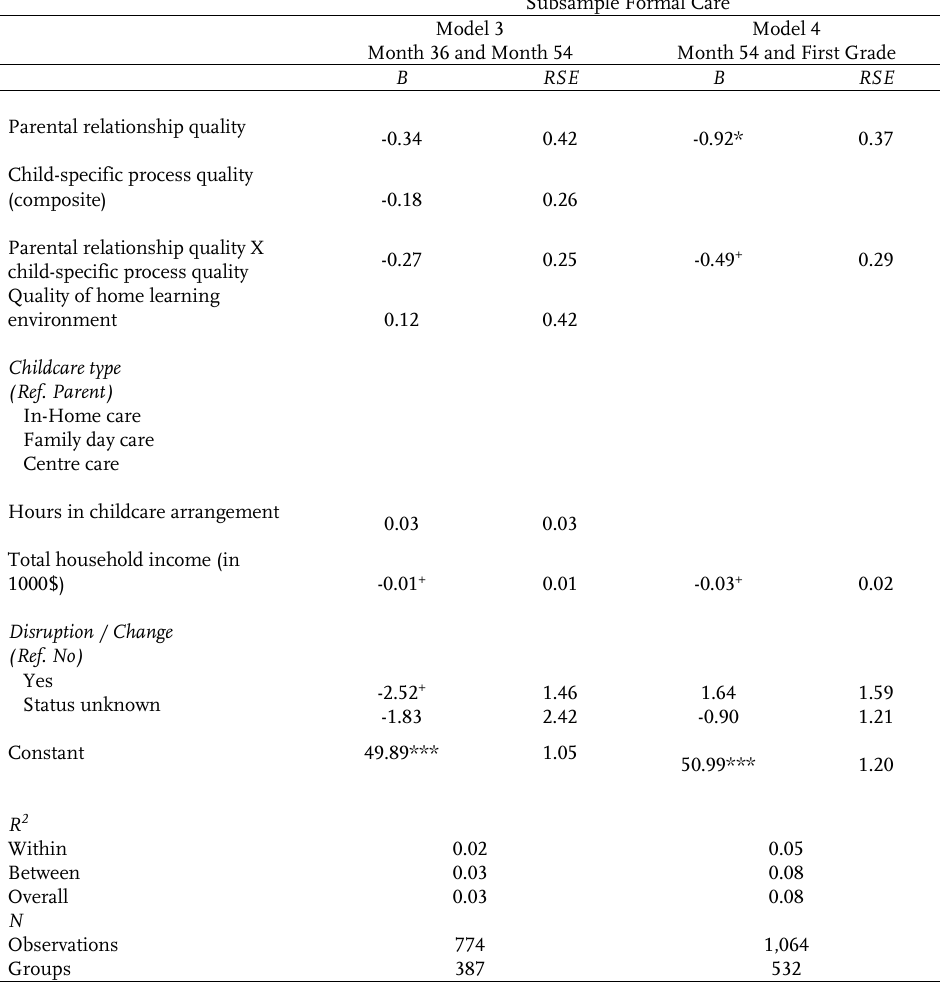
Table 4 : Fixed-effects models of child behavior checklist scores, month 36 through first grade, with ORCE A Priori Qualitative Composite of Process Quality